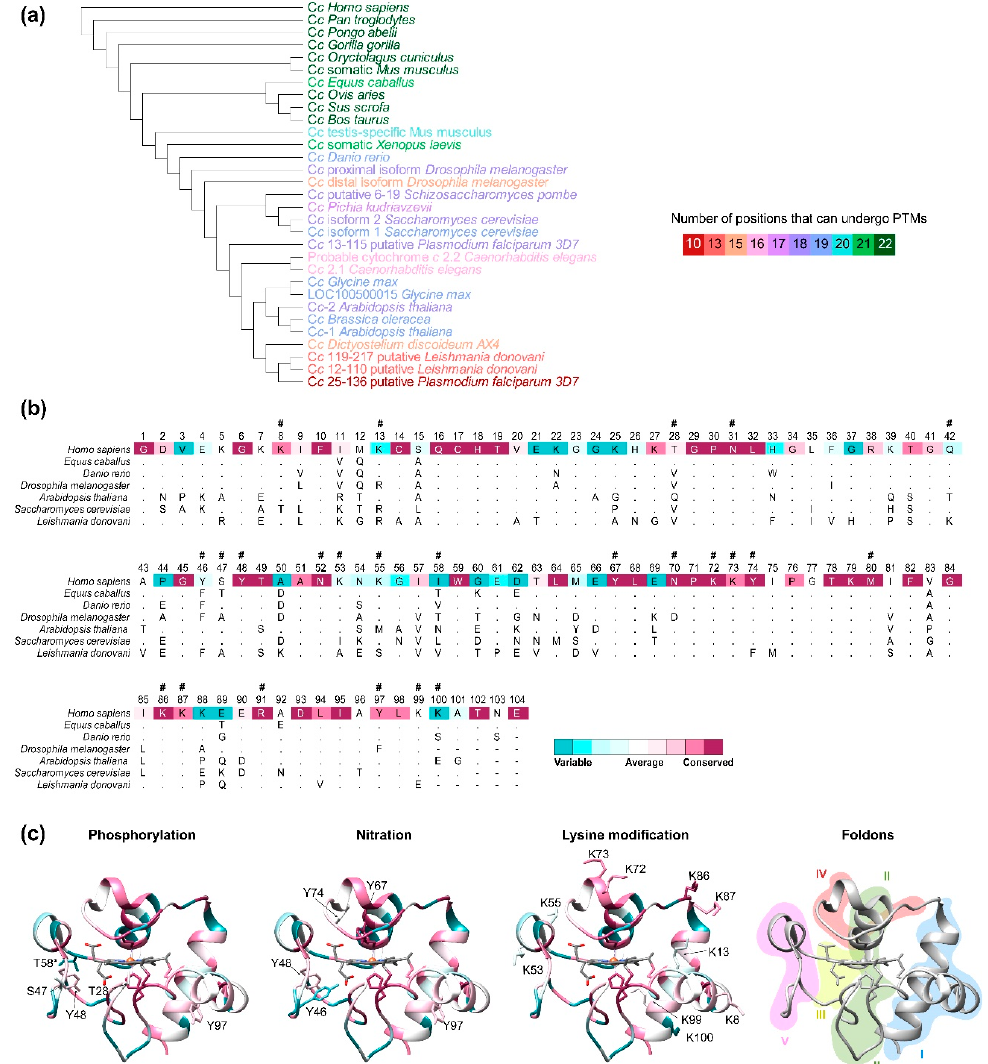
Figure 2. Cytochrome c sequence evolutionary conservation and post-translational modifications. ( a ) Evolutionary analysis by Maximum Likelihood method. The evolutionary history was inferred by using the Maximum Likelihood method and General Reversible Mitochondrial + Freq. model [158]. The bootstrap consensus tree inferred from 500 replicates [159] represents the evolutionary history of the taxa analyzed [160]. Branches corresponding to partitions reproduced in less than 50% bootstrap replicates are collapsed. The percentage of replicate trees in which the associated taxa clustered together in the bootstrap test (500 replicates) are shown next to the branches [160]. Initial tree(s) for the heuristic search were obtained automatically by applying Neighbor-Join and BioNJ algorithms to a matrix of pairwise distances estimated using the JTT model, and then selecting the topology with superior log likelihood value. This analysis involved 31 amino acid sequences. There was a total of 122 positions in the final dataset. Evolutionary analyses were conducted in MEGA X [161]. Labels are colored as a function of the number of amino acid positions that can undergo post-translational modifications (PTMs). ( b ) Sequence alignment and amino acid evolutionary conservation of C c sequences. Residues are colored according to ConSurf conservation score [162]. Amino acids that can be modified are indicated with ( # ). ( c ) Ribbon representation of human C c structure (PDB ID: 2N9I [163]). Left , residues are colored according to conservation score. Side chain of amino acids that undergo PTMs are labelled. Right , the di ff erent foldon units are colored as follows: foldon I in blue, foldon II in green, foldon III in yellow, foldon IV in red, and foldon V in